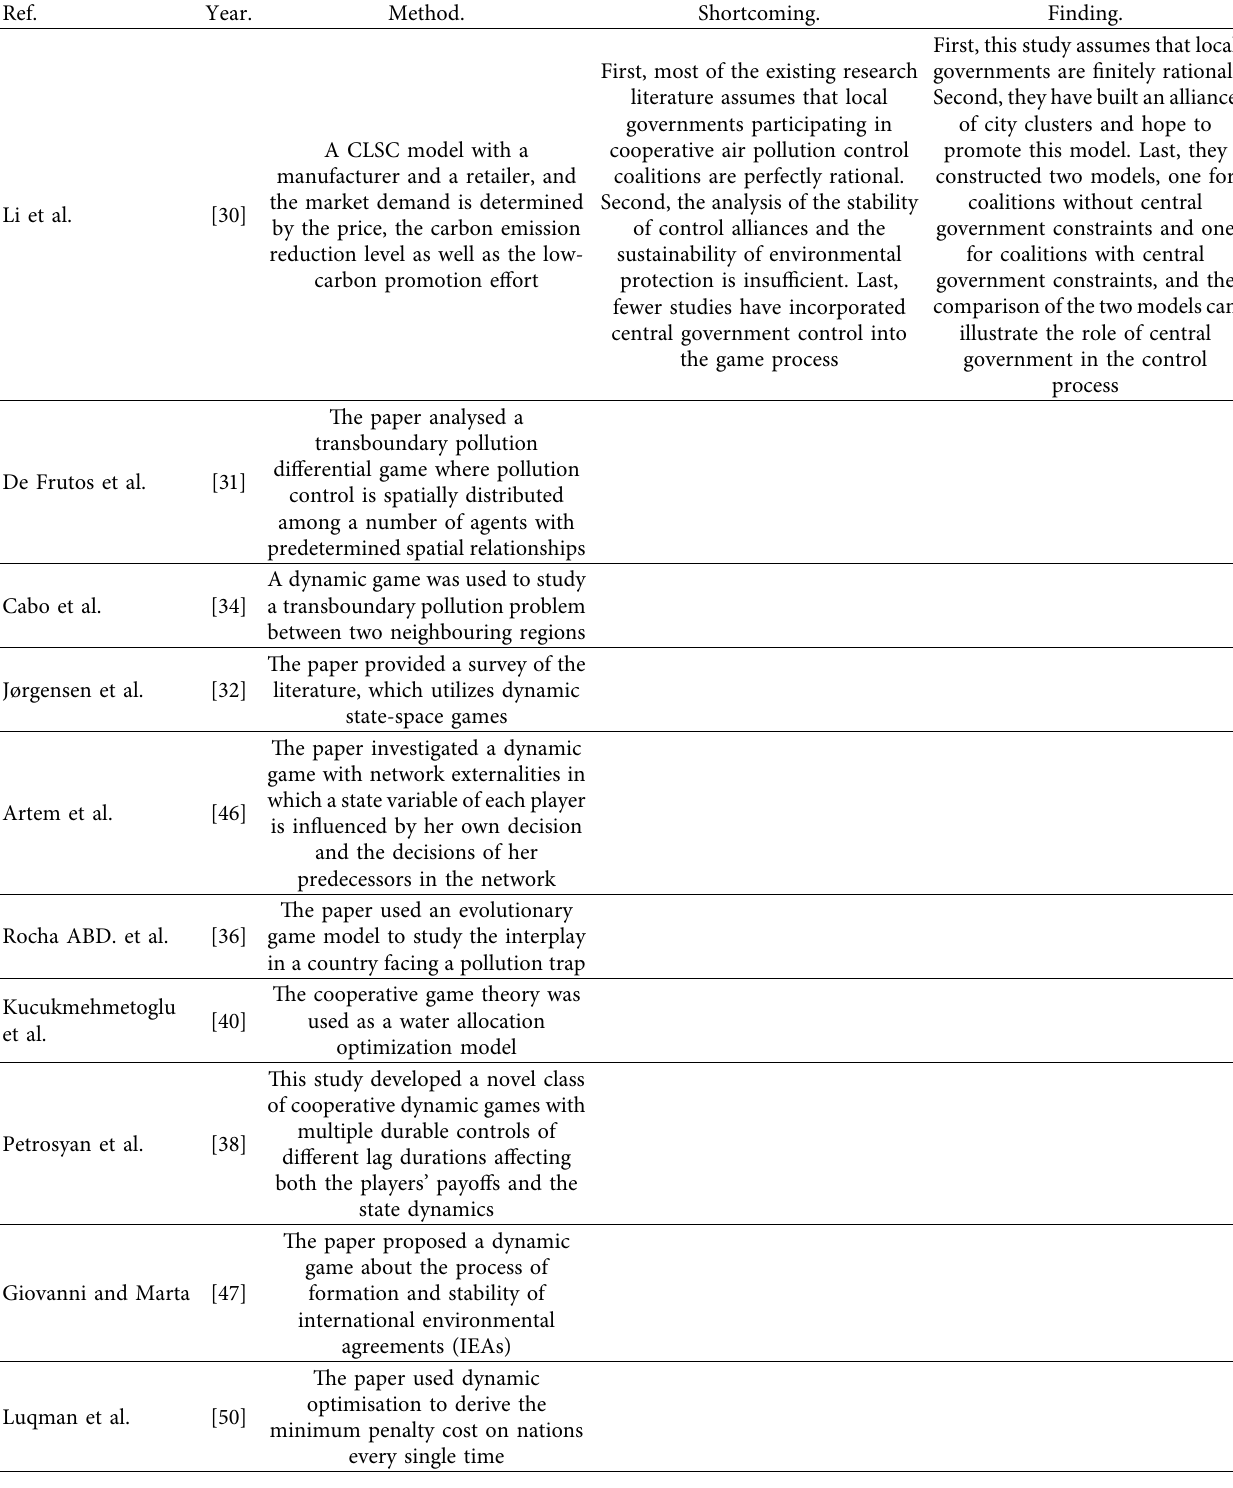
Table 2: A brief summary of most relevant works.